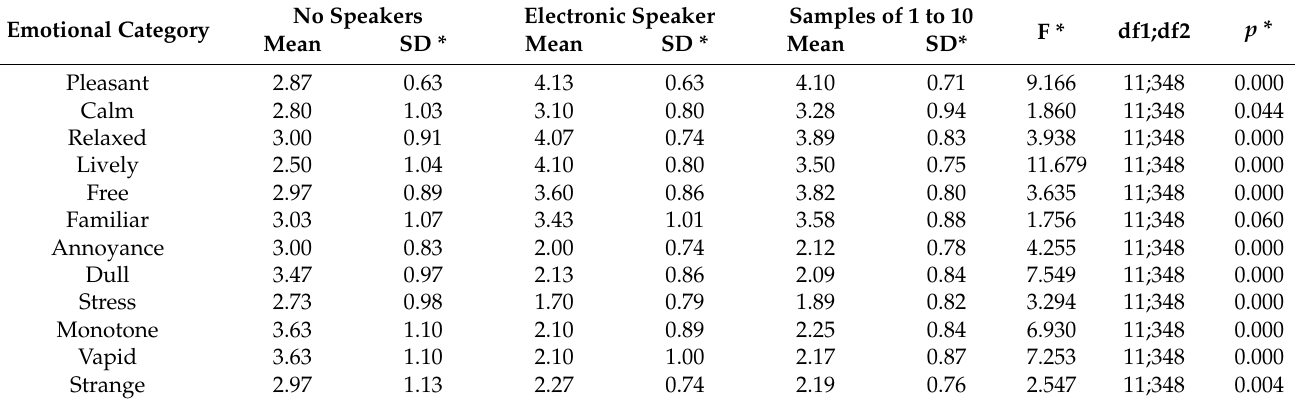
Table 11. Differences between 12 emotional perceptions under different sound conditions (popular